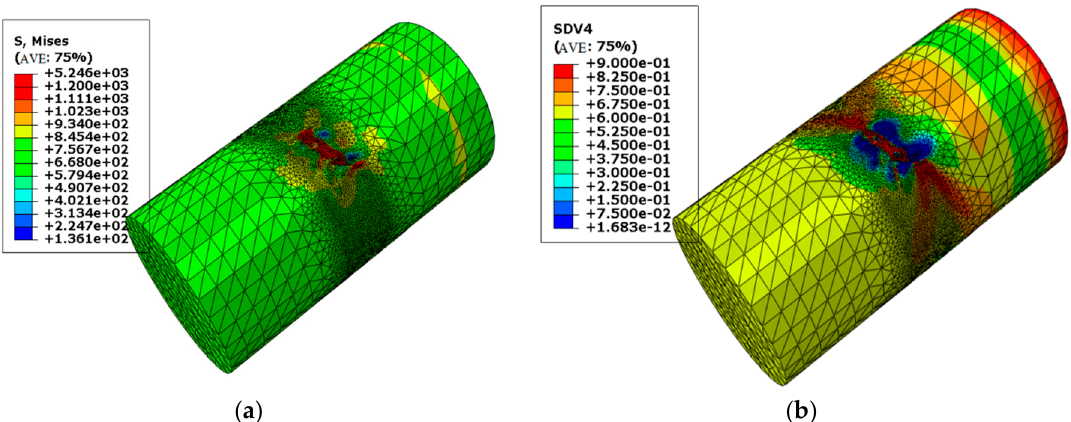
Figure 10. Stress and damage contours of corroded steel wire (step = 195): ( a ) Stress distribution; ( b ) Damage distribution.